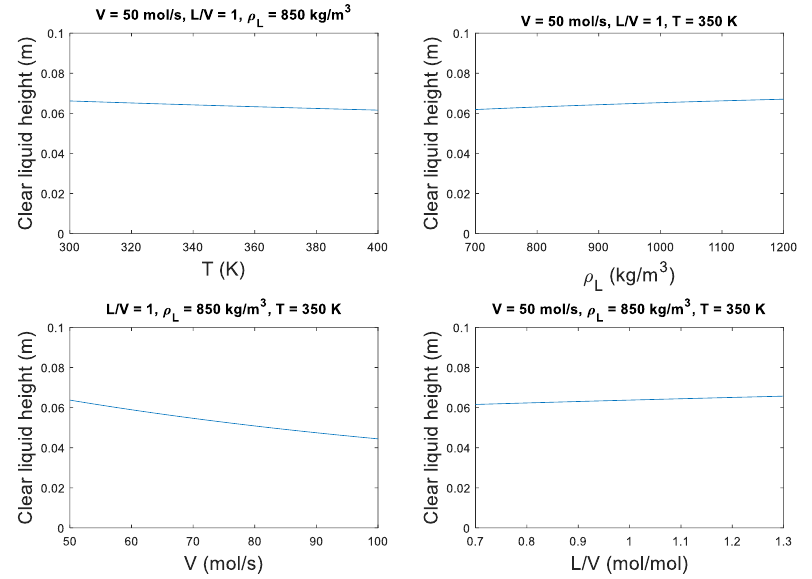
Figure A1. Effect of various parameters on clear liquid height on a sieve tray. A b = 0.8 m, h w = 0.1 m, P = 1 bar, M w = 50 g/mol.